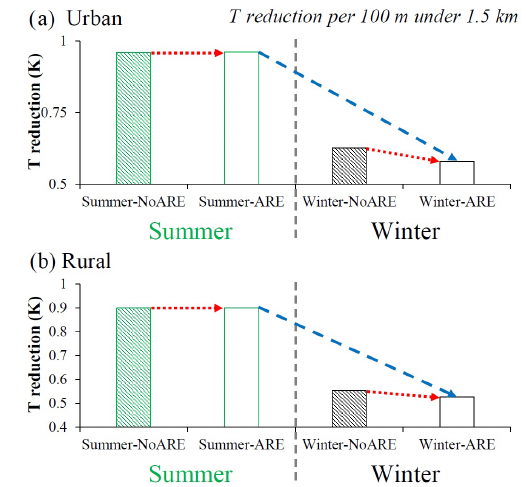
Figure 13. Temperature reductions from model simulations below 1.5km (unit: K(100m) − 1 ) without ARE (white bars) and with ARE (hatched bars) for typical days in summer (green) and win- ter (black) in (a) urban areas and (b) rural